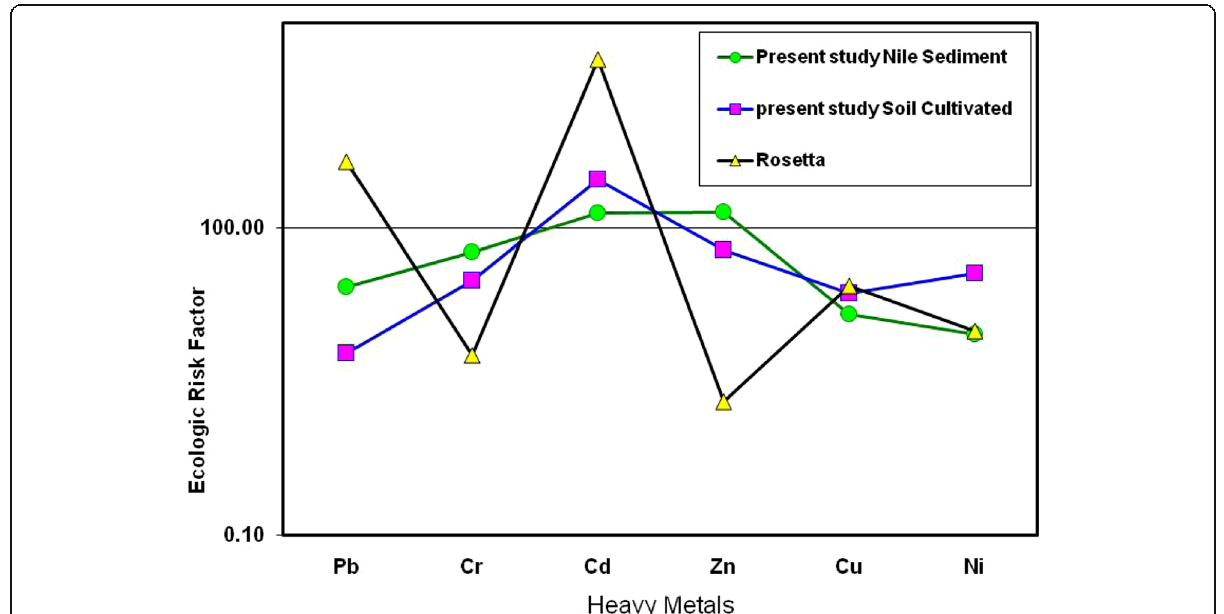
Fig. 8 Comparison of the contamination factor of the study of Nile sediment and soil cultivated with Rosetta samples.